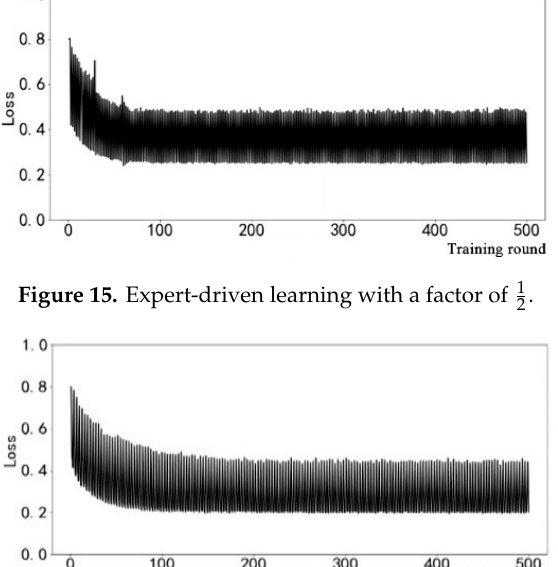
Figure 16. Expert-driven learning with a factor of 2/3.